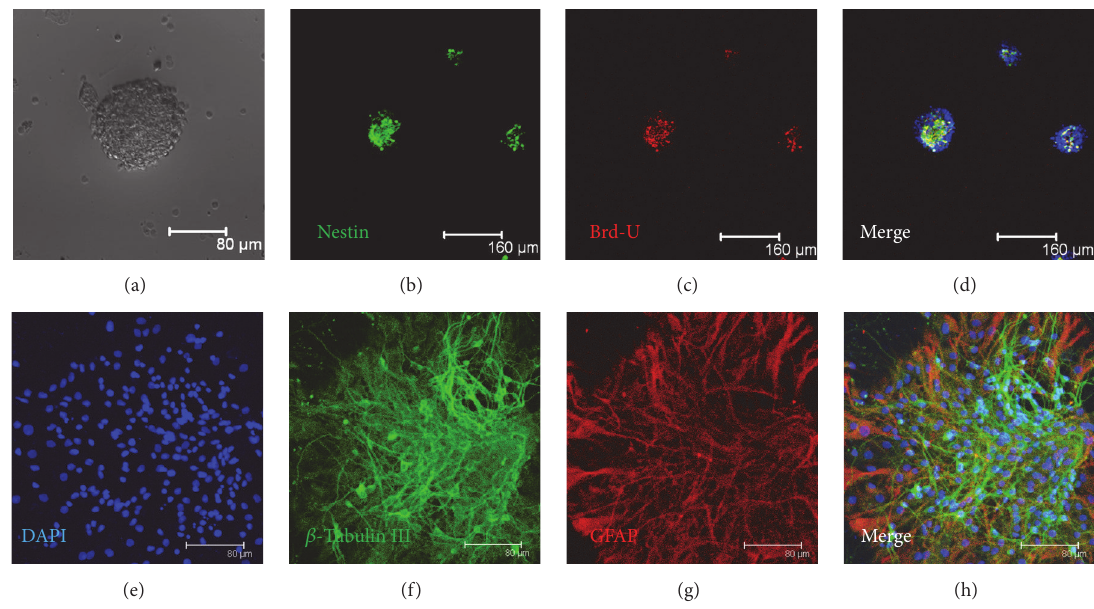
Figure 1: Identification of primary cultured NSCs in vitro . (a) Representative neurospheres in culture. ((b)–(d)) Immunocytochemical staining of purified NSCs with Nestin ((b), green) and Brd-U ((c), red) and merged with nucleus staining DAPI ((d), blue) (bar = 160 𝜇 m). ((e)–(h)) Nucleus staining ((e), blue) and immunocytochemical of differentiated astrocytes with 𝛽 -tubulin III ((f), green) and GFAP ((g), red) and merged with (h) (bar = 80 𝜇